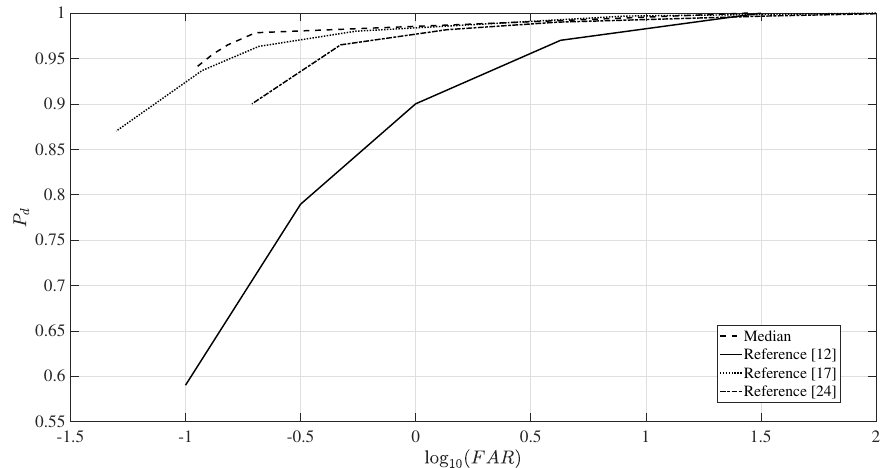
Figure 8. The receiver operating characteristic (ROC) curves obtained with the CDA with the background predicted scene as the reference image compared with the best ROC curves extracted from